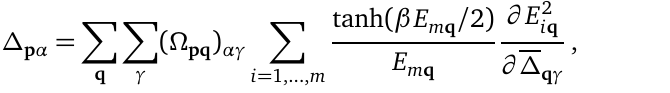
Figure 2: Superconducting order parameters arising from 3 with i = 1,2,3 denoting the components of the three-dimensional irreps, from the novel fixed point Kondo interaction. Coupled order parameters have an intersection between their depicted circles. The Cooper pair operators associated with the order parameters are detailed in Appendix E. The complete form of the pairing Hamiltonian is presented in Appendix